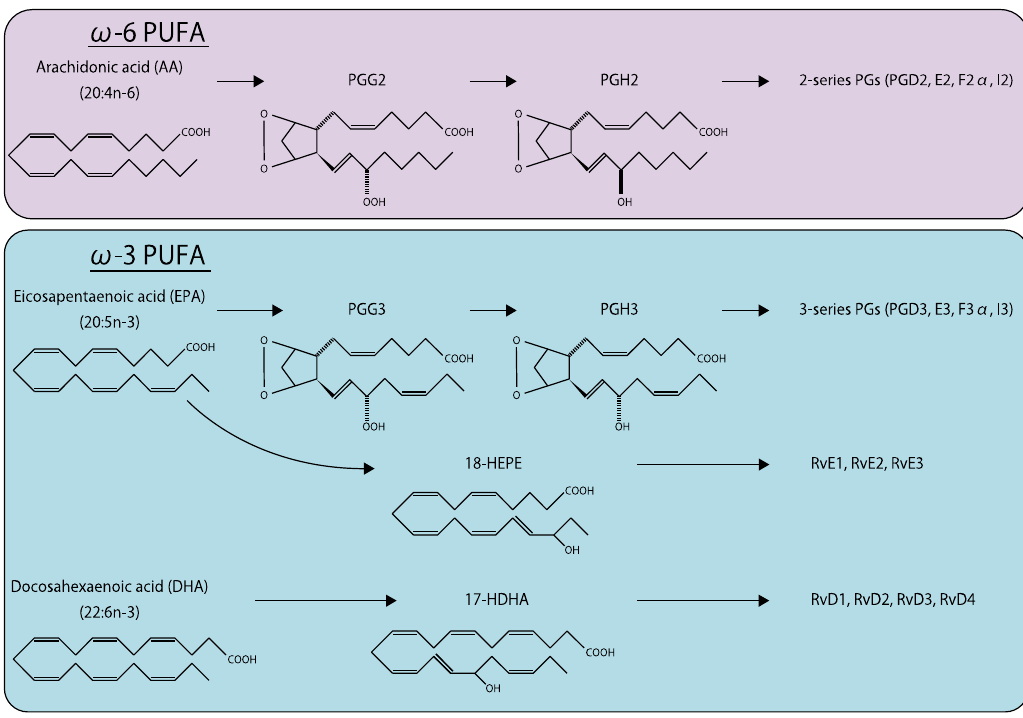
ω -6 and ω -3 fatty